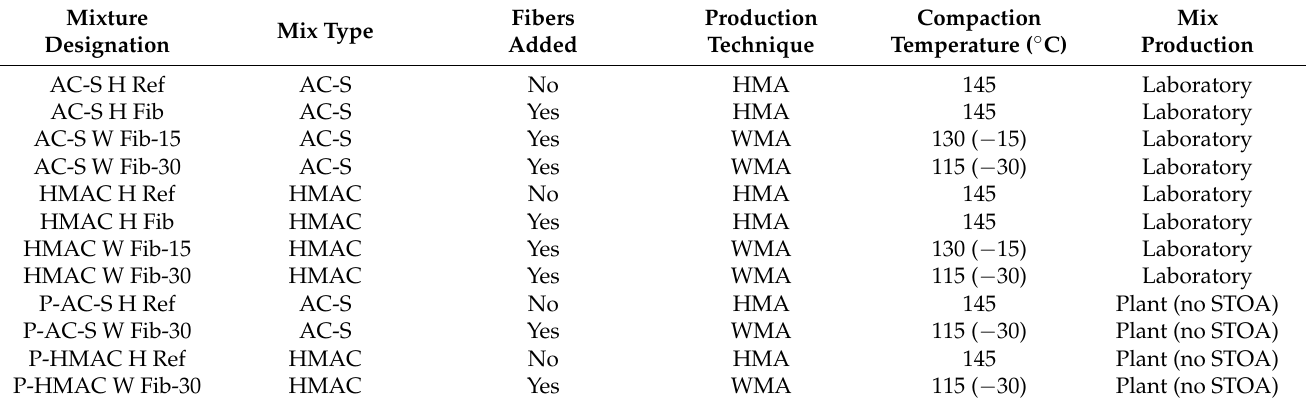
Table 1. Specifications of the investigated mixtures.